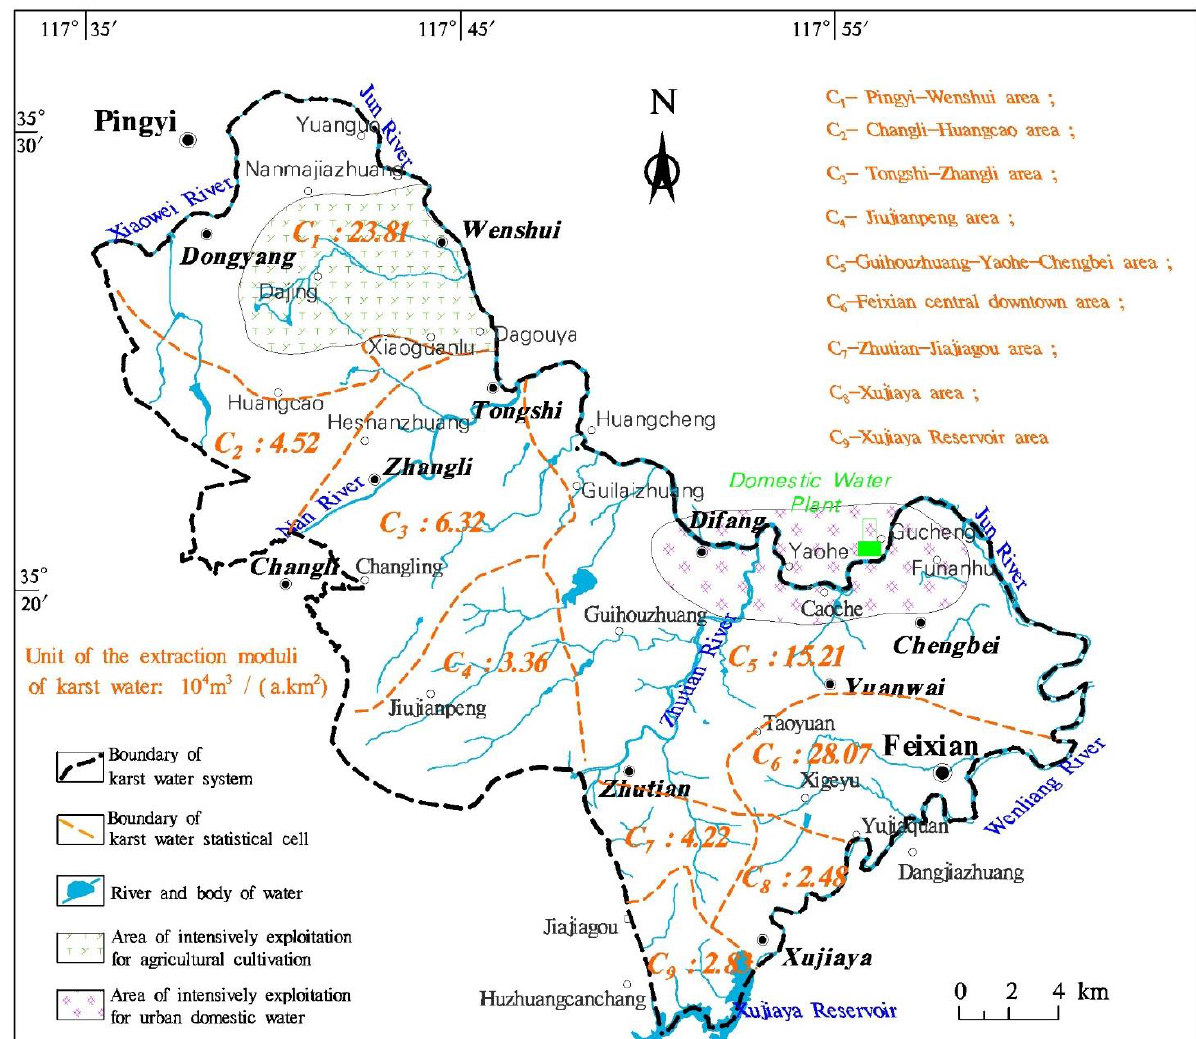
Figure 3. Zoning of the study region to calculate the extraction modulus of karst water.